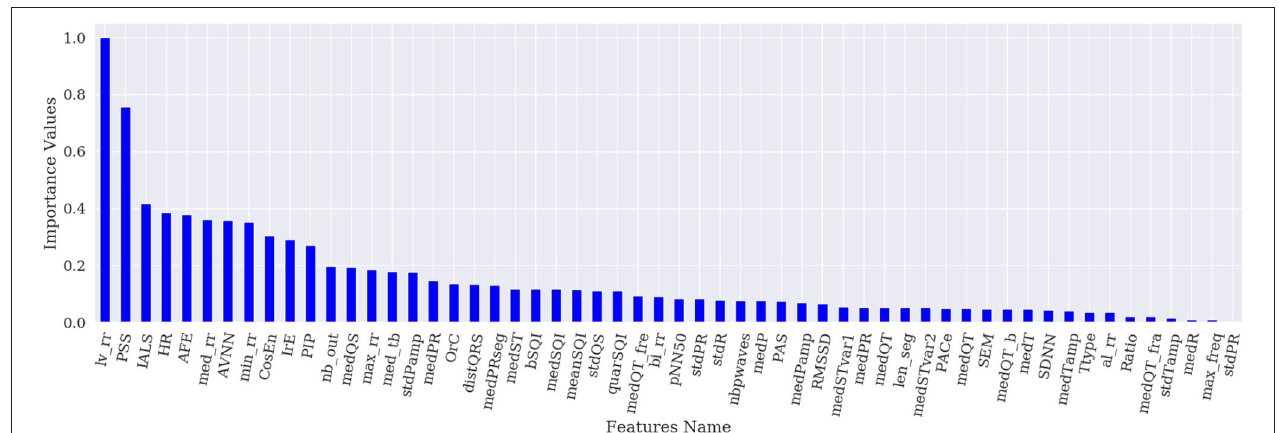
Frontiers in Physiology |